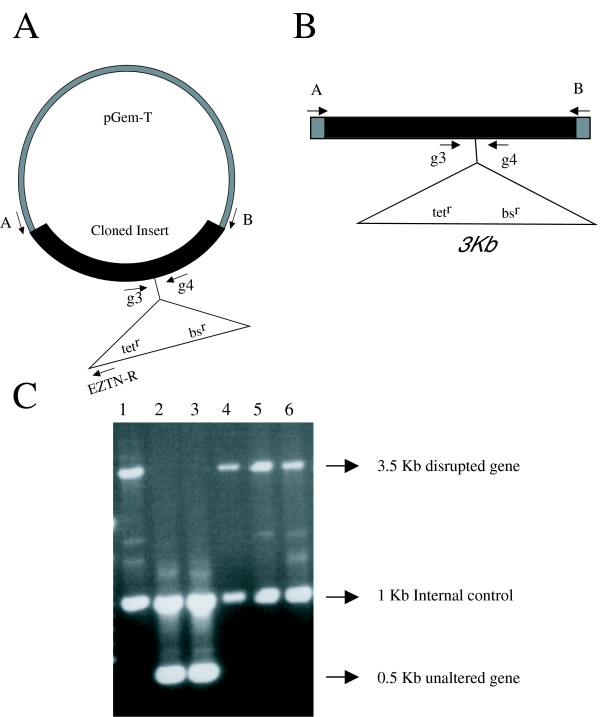
Rapid analysis of gene disruption by PCR. Panel A shows a diagram of a hypothetical disruption construct in which the cloned gene has been interrupted by the transposon. This construct was used as template for PCR with oligos A and B. The resulting fragment (depicted in panel B) was transfected into Dictyostelium cells. Panel C shows an example of the analysis of clonal isolates after transformation and selection with blasticidin. PCR with primers g3 and g4 generates a 0.5 Kb band, which is absent when the gene has been disrupted (lanes 1,4,5,6). The upper band confirms the insertion of the 3 Kb transposon in the locus.